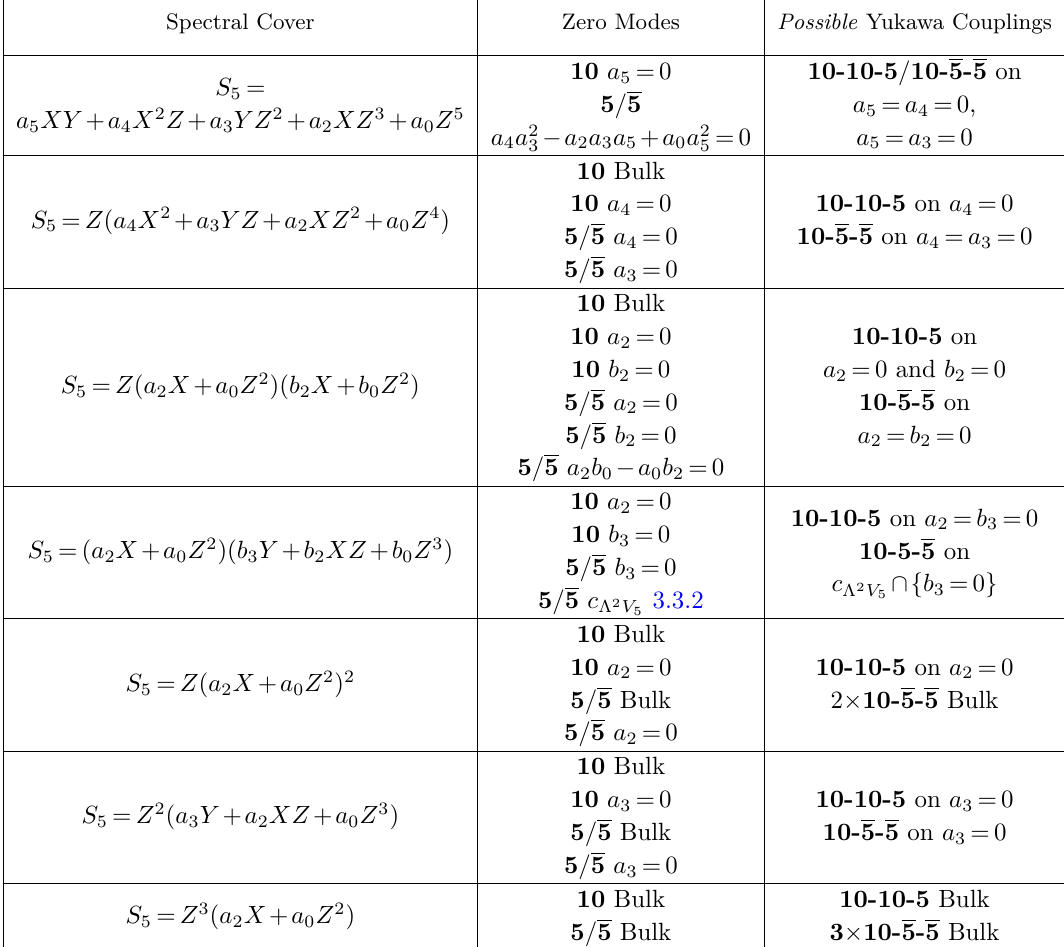
Table 3 . SU(5) models possible Yukawa couplings. The middle column corresponds to the zero modes that can have non-zero Yukawa